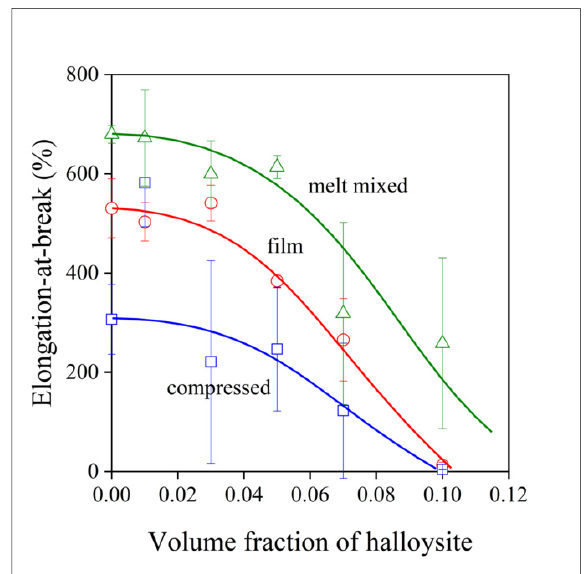
Figure 8. Dependence of the deformability of PCL/halloysite composites on filler content. Symbols: (  ) film, (  ) compressed, (  ) melt